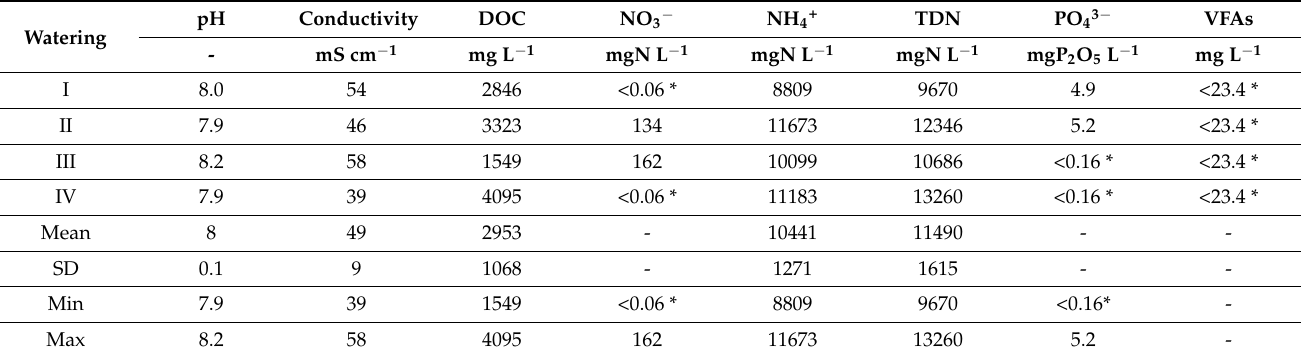
Table 1. Physico-chemical parameters of the leachates. Min and Max: the values measured during the trial for each parameter ( n = 4, except for NO 3 − and PO 43 − ); and *: LOQ.